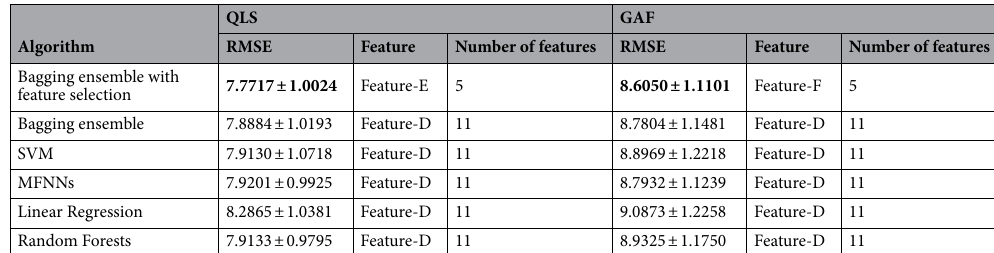
Table 2. The results of repeated tenfold cross-validation experiments for predicting the QLS and GAF functional outcome of schizophrenia with cognitive function scores using machine learning predictors such as the bagging ensemble model with feature selection, the bagging ensemble model, MFNNs, SVM, linear regression, and random forests. The best QLS or GAF scores are given in bold. Feature-D : 11 features (related to 11 cognitive function scores) including category fluency, trail making A, WAIS-III digit symbol- coding, d-Prime of clear version, d-Prime of blurred version, verbal working memory, nonverbal working memory, verbal learning and memory, visual learning and memory, reasoning and problem solving, and social cognition. Feature-E : 5 features (related to 5 cognitive function scores) including category fluency, WAIS-III digit symbol-coding, verbal working memory, nonverbal working memory, and social cognition. Feature-F : 5 features (related to 5 cognitive function scores) including category fluency, WAIS-III digit symbol-coding, d-Prime of blurred version, verbal working memory, and reasoning and problem solving. GAF = Global Assessment of Functioning; MFNNs = Multilayer Feedforward Neural Networks; QLS = Quality of Life Scale; RMSE: Root Mean Square Error; SVM = Support Vector Machine. Data are presented as mean ± standard